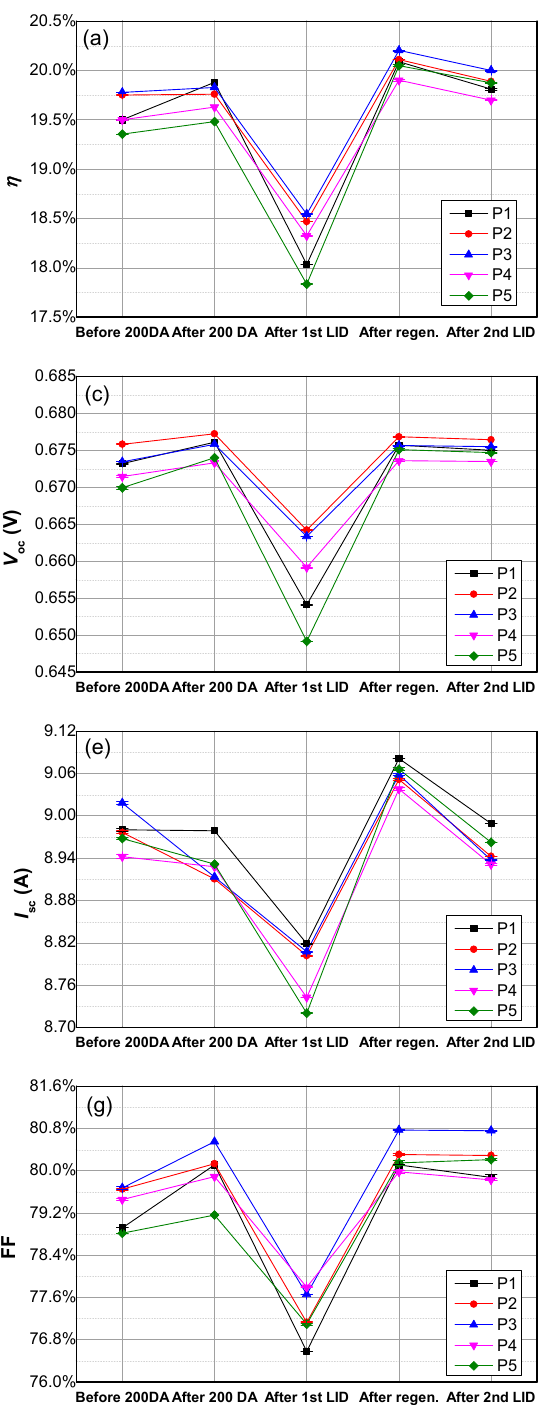
Figure 3. Variations of I - V characteristic parameters of five groups of PERC ( left column) and Al-BSF cells ( right column) measured at STC condition with process steps. (a) η of PERC cells; (b) η of Al-BSF cells; (c) V oc of PERC cells; (d) V oc of Al-BSF cells; (e) I sc of PERC cells; (f) I sc of Al-BSF cells; (g) FF of PERC cells; (h) FF of Al-BSF cells.